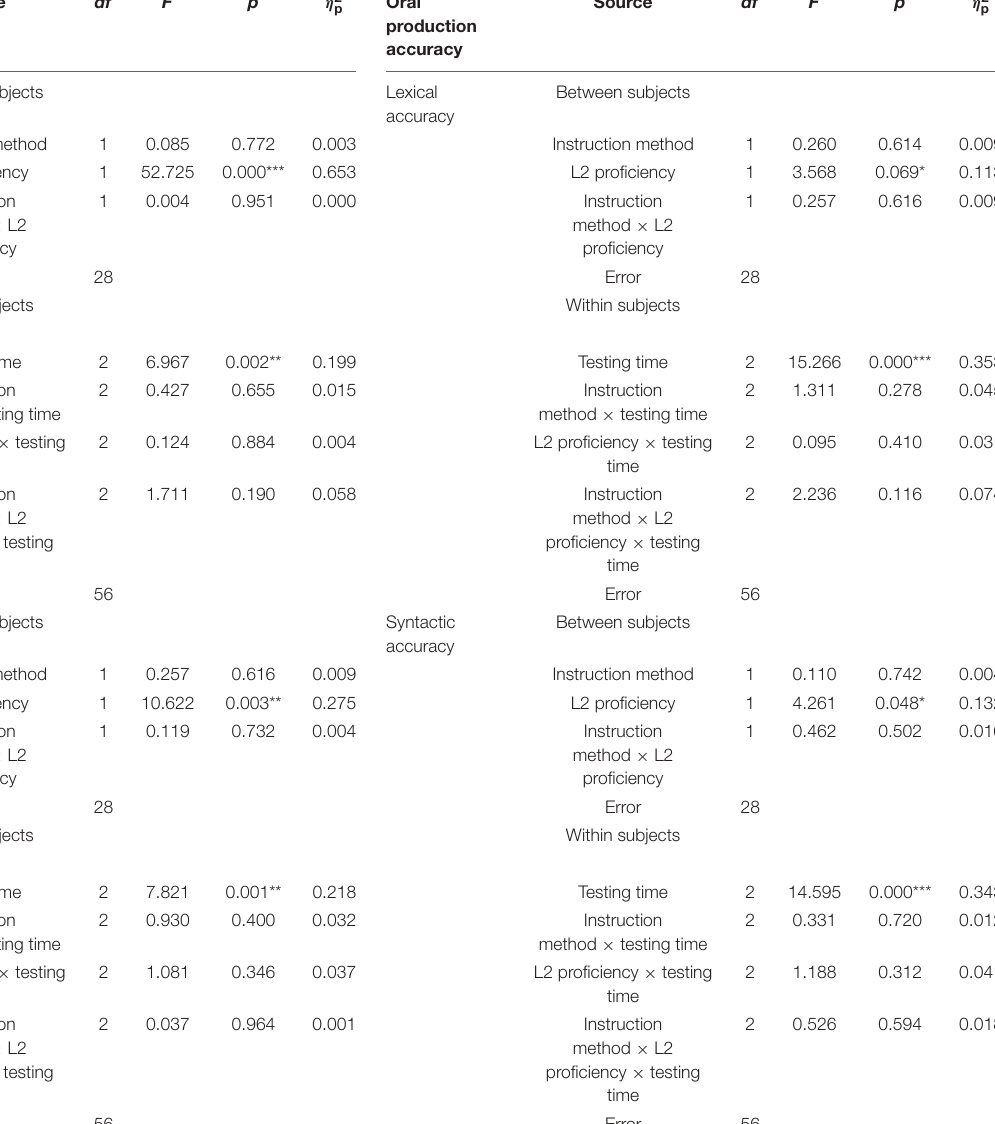
TABLE 5 | Results of three-factor mixed ANOVA for oral production complexity. TABLE 6 | Results of three-factor mixed ANOVA for oral production